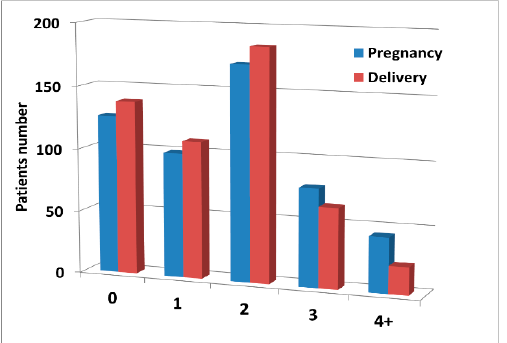
Figure 2. The graph shows the number of patients (vertical axis) corresponding to the number of pregnancies (blue bars) or the number of deliveries (red bars) per individual, respectively (horizontal axis). “4+”: 4 or more. Note that the bars corresponding to the number of deliveries differ from the respective “Pregnancy” bars due to miscarriages.